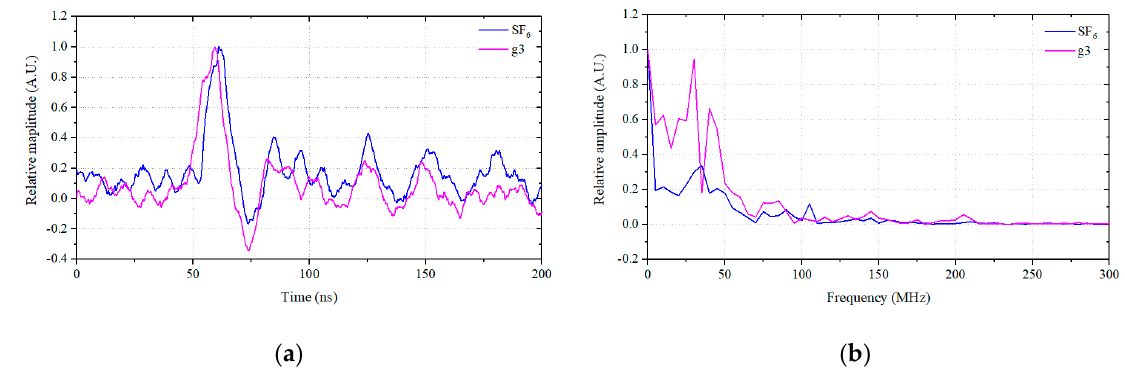
Figure 4. PD pulse and its fast Fourier transform (FFT) in SF 6 and g3 in the POC. ( a ) In time domain; ( b ) In frequency domain.